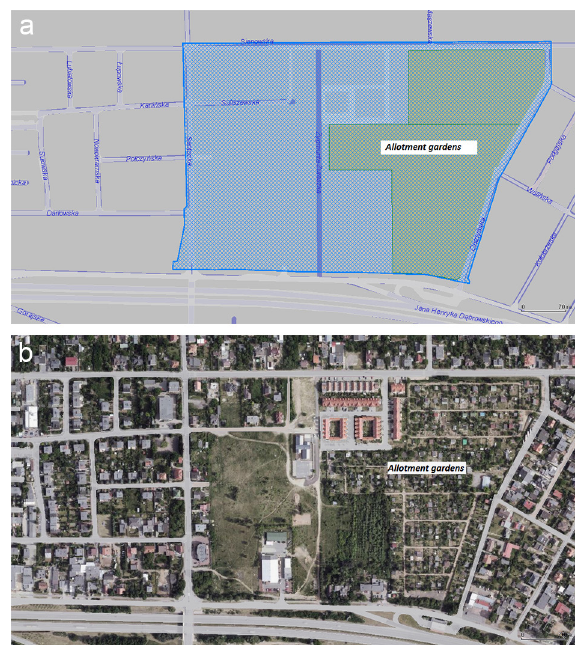
Fig. 1. Allotment gardens „Zjednoczeni” and „Olszynka” a) covered by MPZP adopted in 2003, and b) still existing on the satellite image from